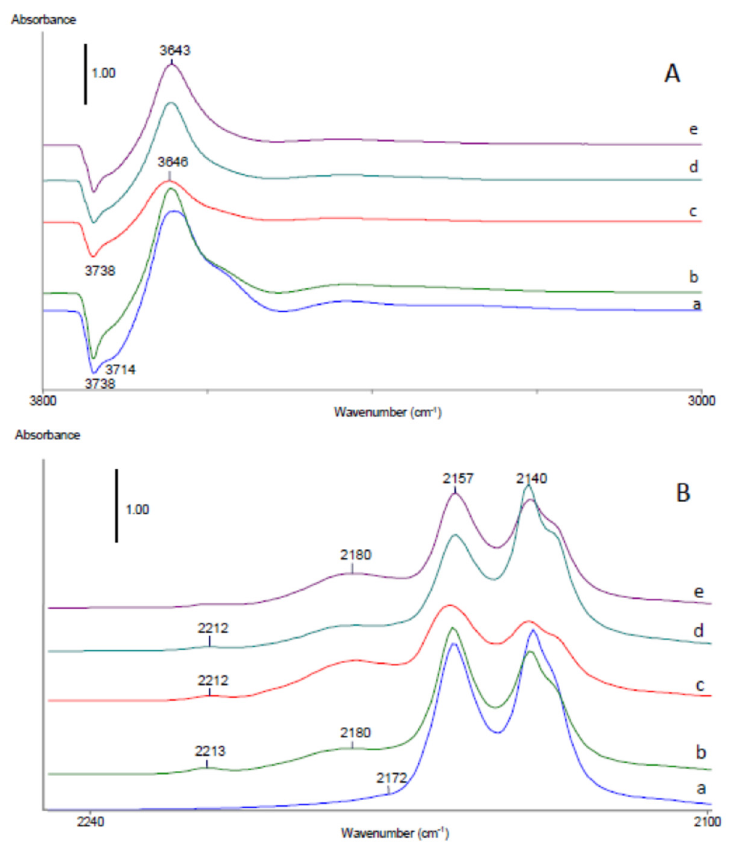
Figure 12. FTIR difference spectra in hydroxyl ( A ) and carbonyl ( B ) stretching ranges of SiBEA, Co 1.0 SiBEA(I), Co 5.0 SiBEA(I), Co 1.0 SiBEA(III), and Co 5.0 SiBEA(III) after adsorption of CO (equilibrium pressure 133 Pa) at − 173 °C then evacuation to equilibrium CO pressure of 10 Pa.